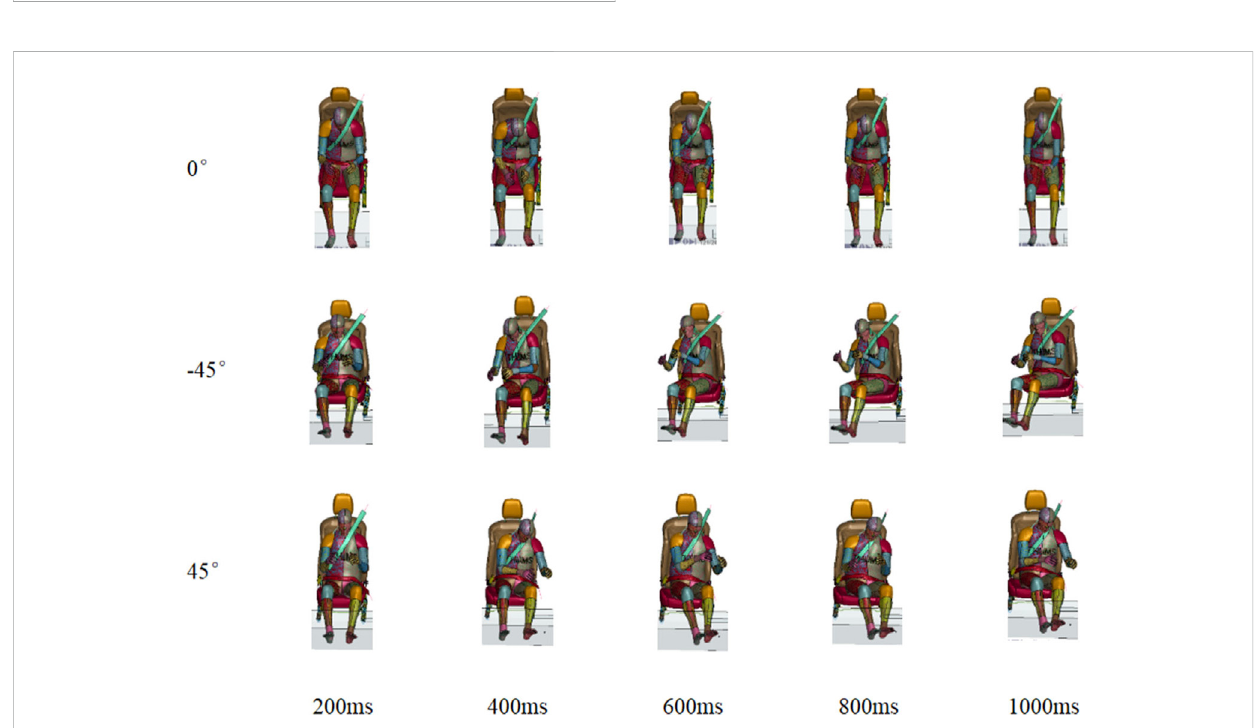
FIGURE 10 Occupant kinematics in 0 ° , − 45 ° and 45 ° seat